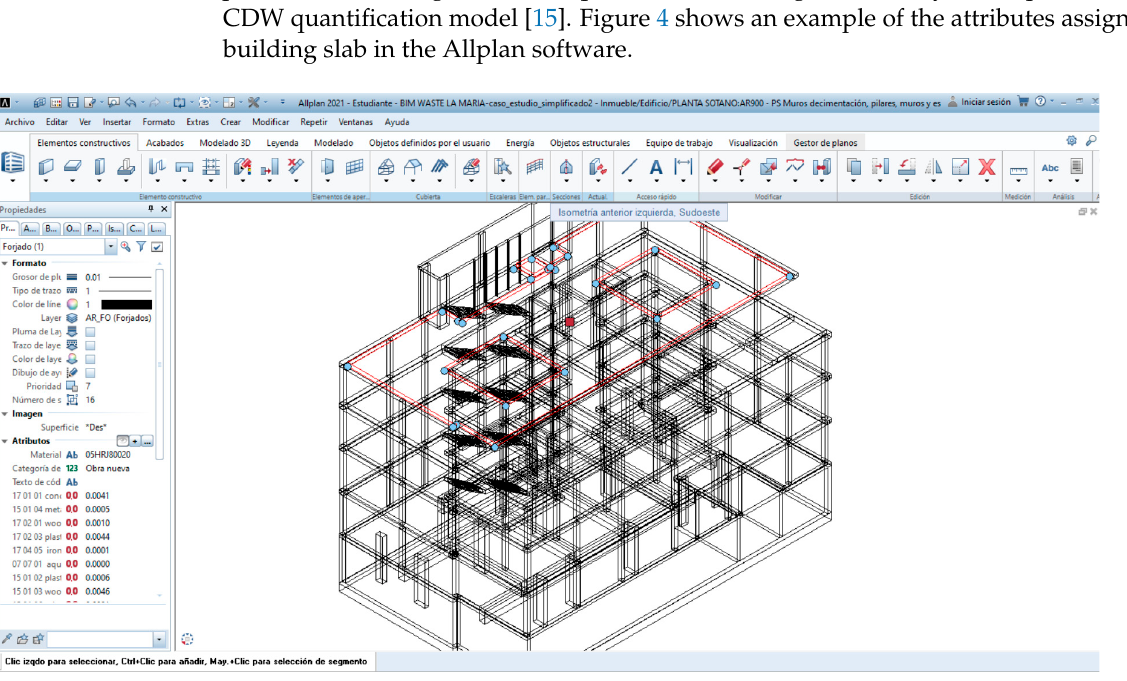
Figure 4. Example of the slab properties panel in Allplan: waste types with assigned values per unit of measure.